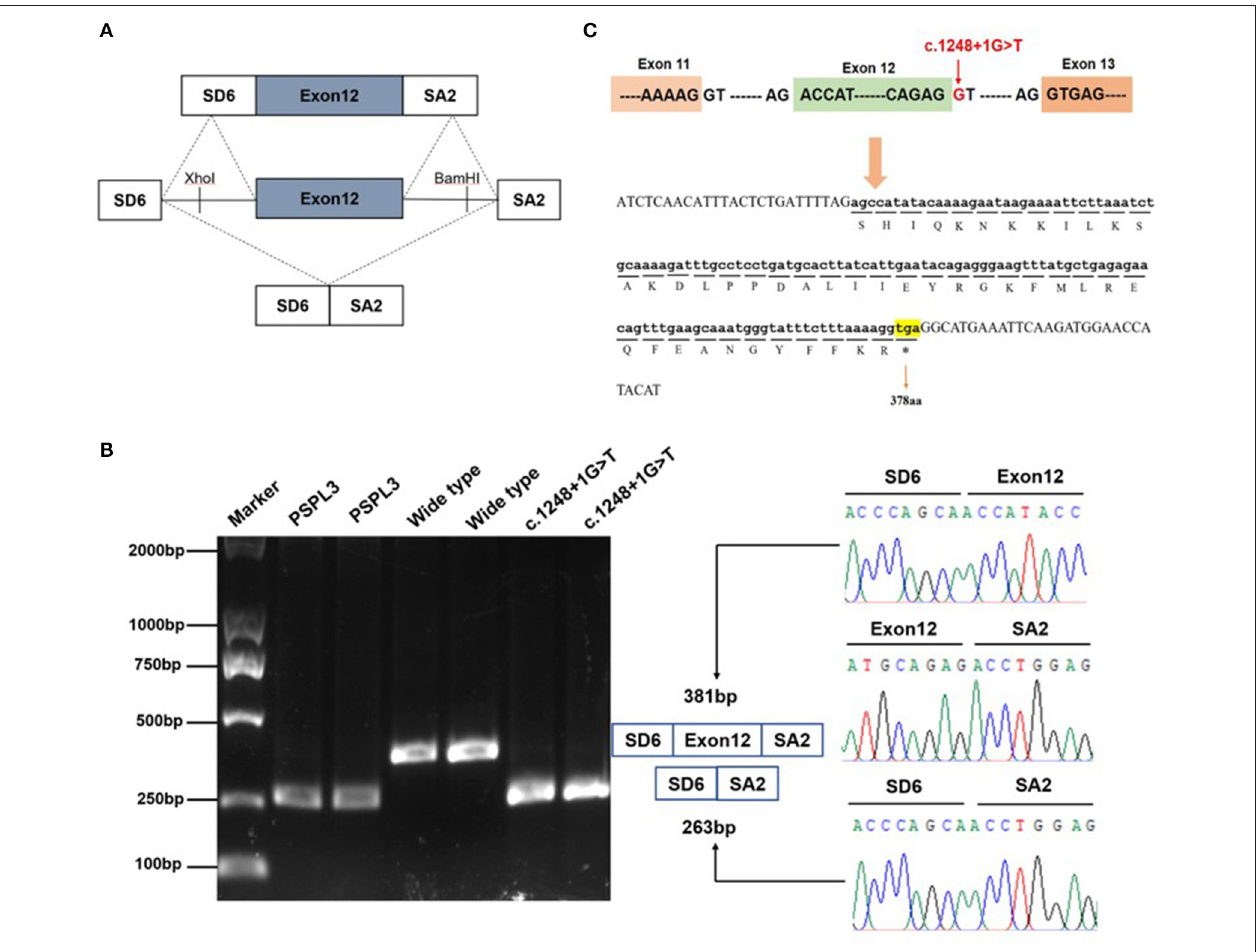
FIGURE 2 | Effect of the KMT2E gene c.1248 + 1G > T variant determined by minigene assays. (A) The pSPL3 vector contains 2 exons SD6 and SA2, and a functional intron. All of the indicated fragments were separately cloned into the XhoI and BamHI cloning sites of the pSPL3 vector. SD6 and SA2 primers were designed for RT-PCR amplification of cDNA sequences generated by transfected HEK293 cells. (B) Gel electrophoresis of the RT–PCR products of minigene transcripts in HEK293 cells. Lane 1: marker; Lane 2 and 3: pSPL3 (263 bp); Lane 4 and 5: E12-wide type (381 bp); Lane 6 and 7: c.1248 + 1G > T (263 bp). The two fragments were directly sequenced (right panel). Sequencing analysis of the cDNA showed that the shorter transcript lacked a sequence corresponding to exon 12 of the KMT2E gene. (C) Exon 12 and adjacent structures in the KMT2 gene. The arrow shows the location of the c.1248 + 1G > T splice variant and its effect at the amino acid level. The variant caused by a premature stop codon at amino position